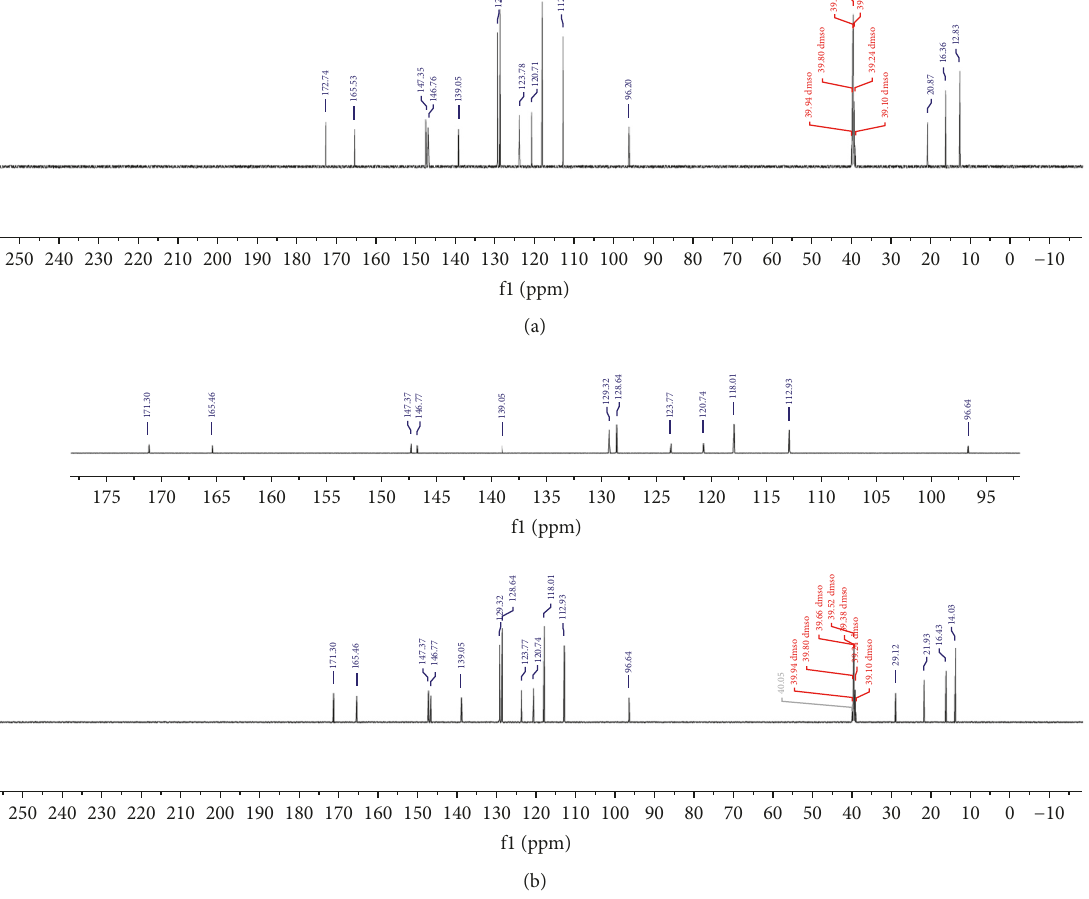
Figure 3: (a) 13 C NMR spectrum of Empp-Ph; (b) 13 C NMR spectrum of Prmpp-Ph.